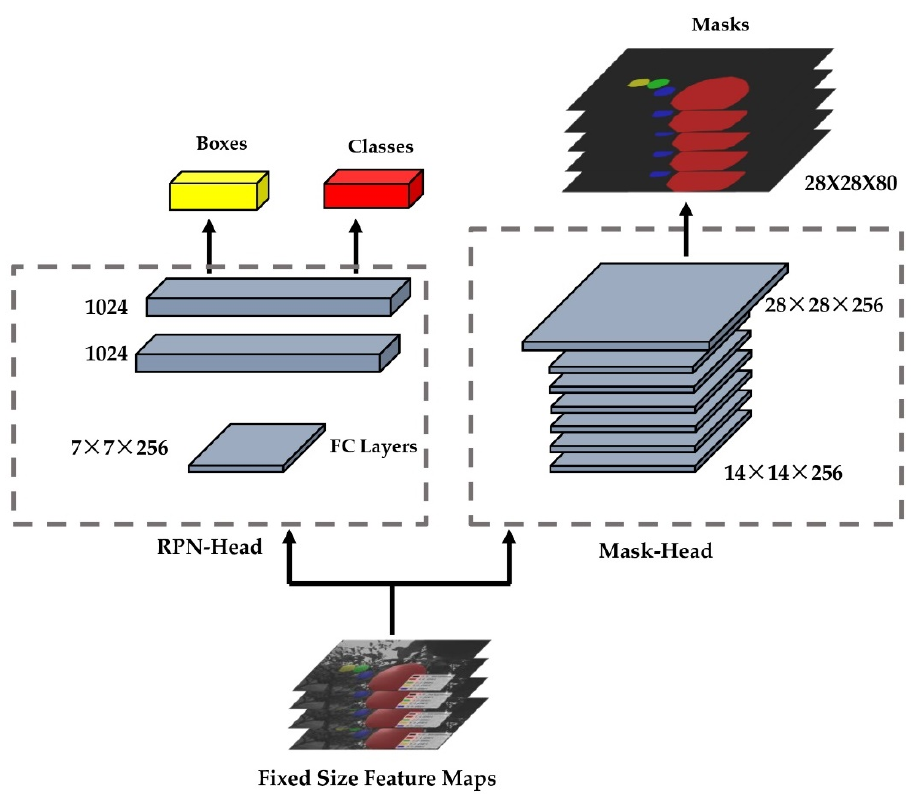
Figure 9. Flow diagram of feature maps to produce boxes, classes, and masks for each pear in each fixed-size feature map after ROI-Align.